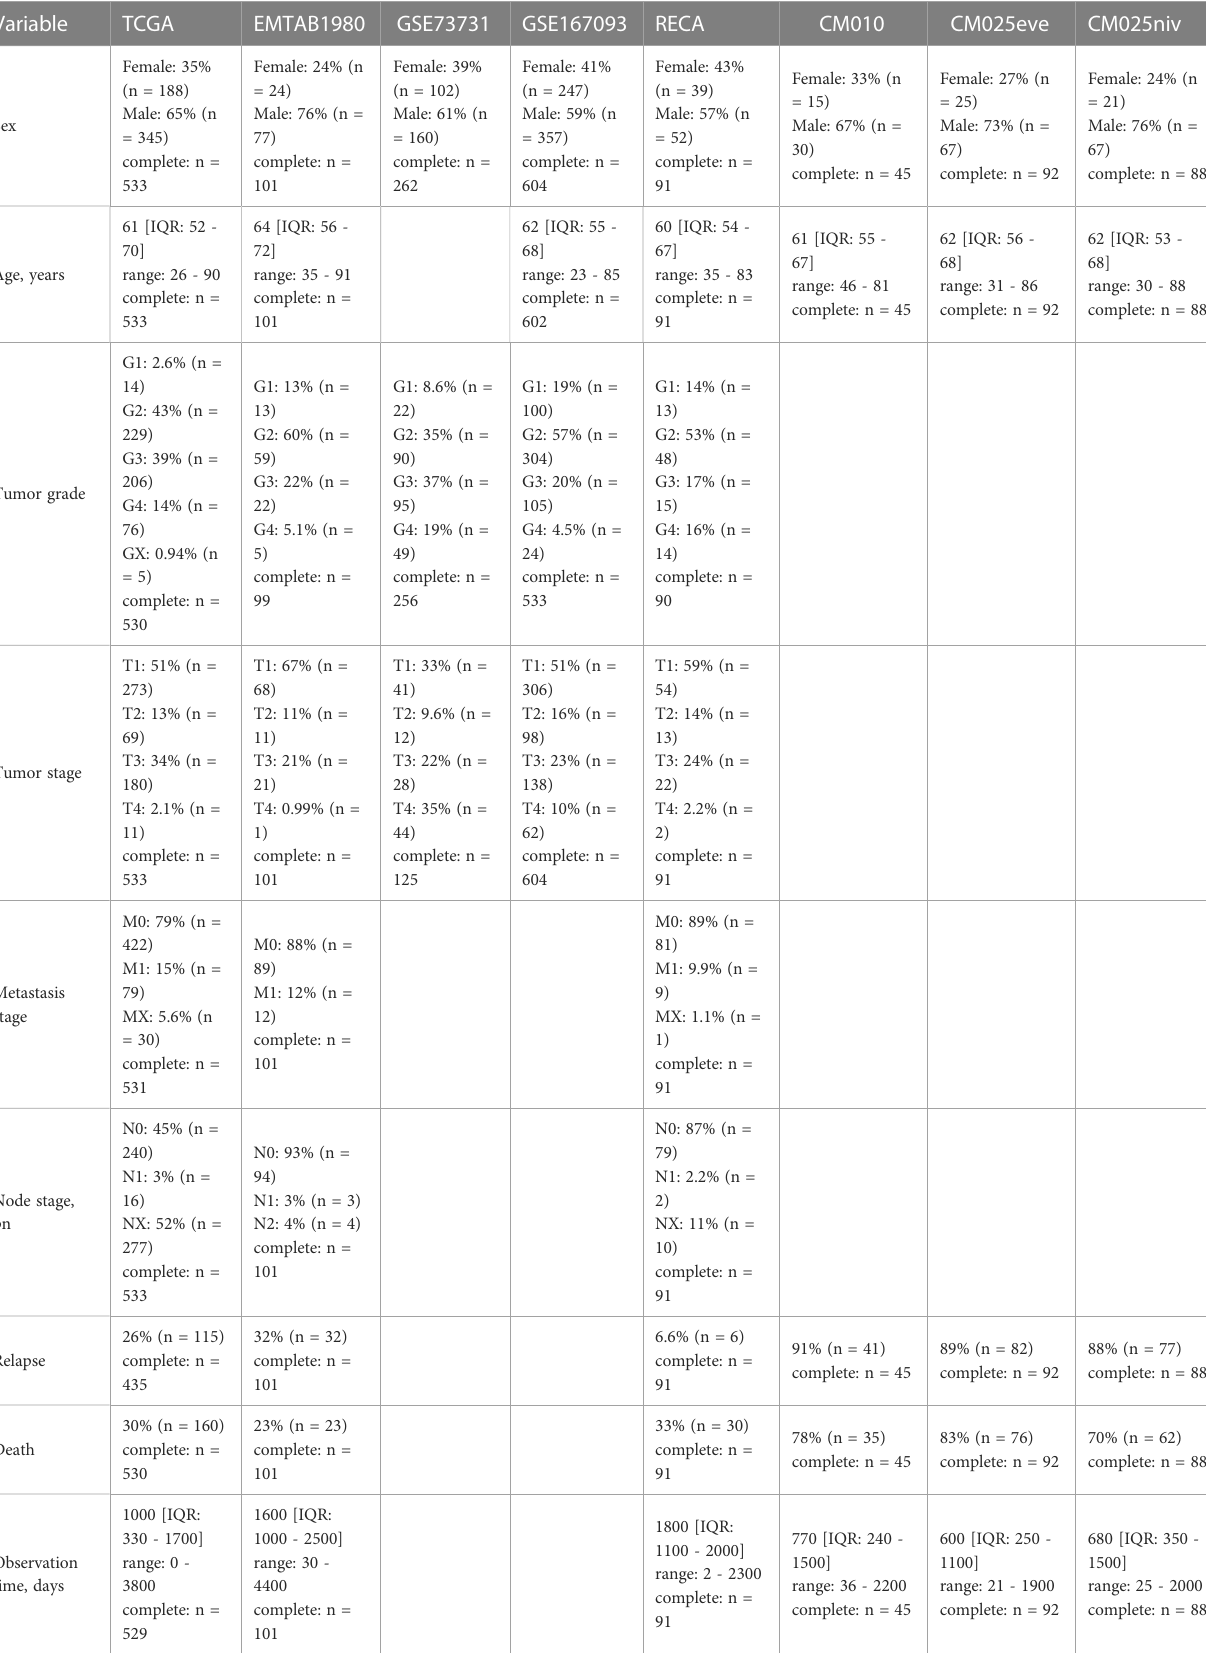
TABLE 1 Characteristic of the study cohorts. Numeric variables are presented as medians with interquartile ranges and ranges. Variable